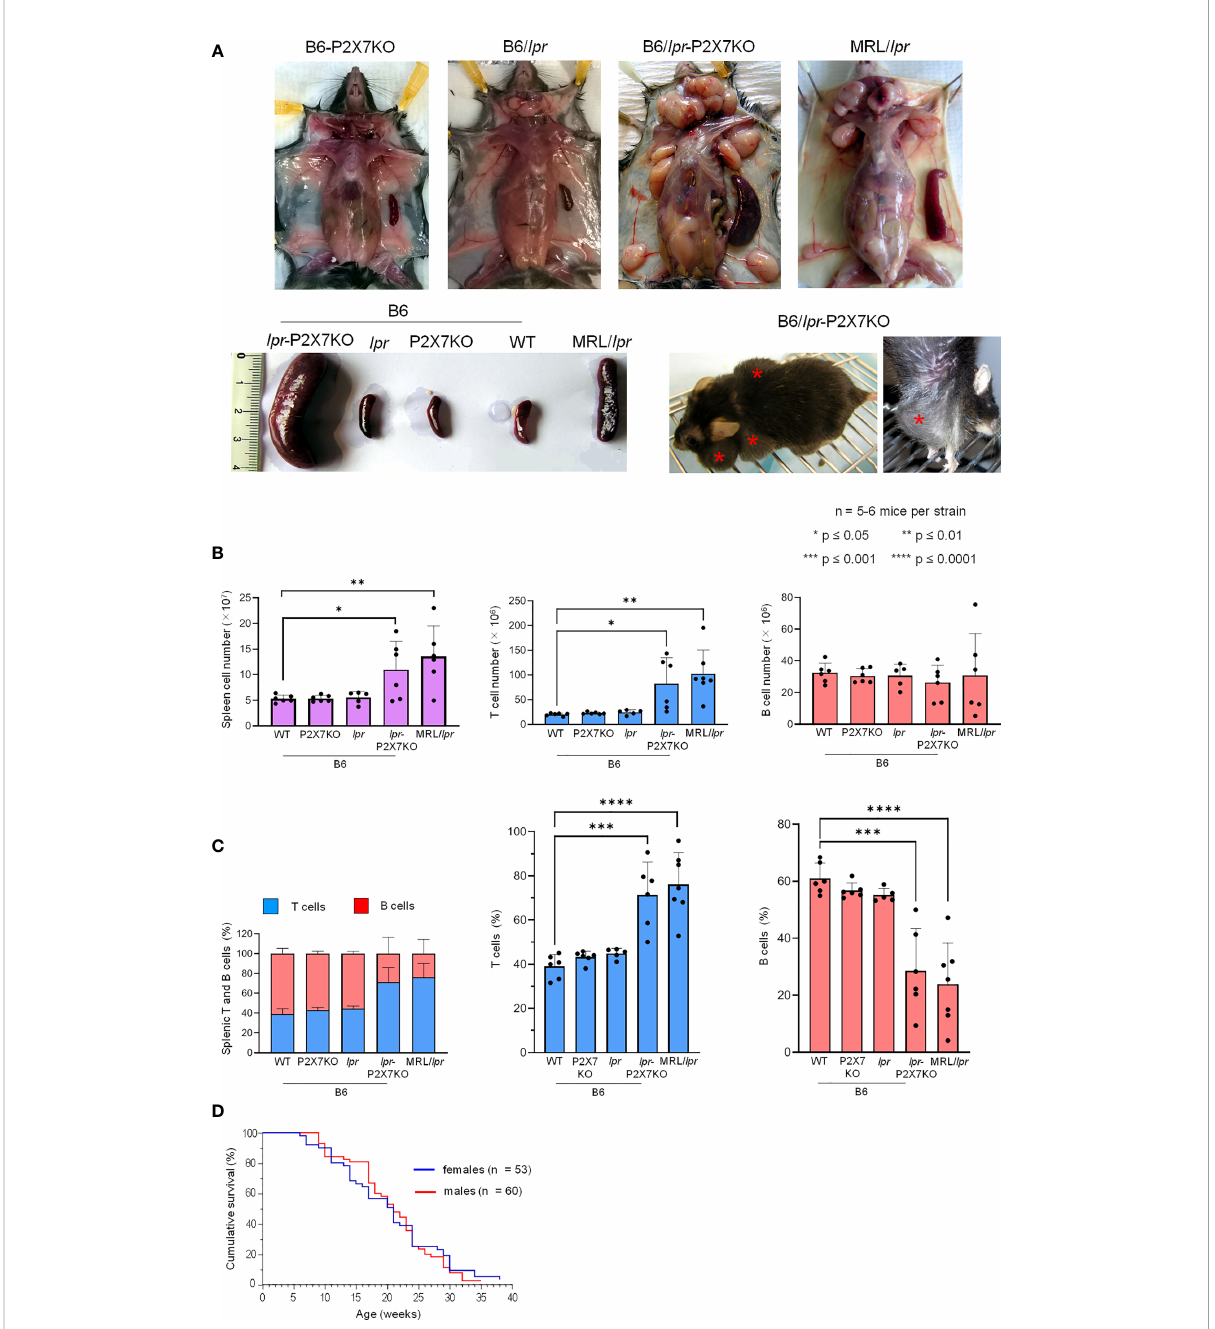
DC FIGURE 1 B6 /lpr-p2x7 KO mice show a shortened lifespan and develop massive hyperplasia of the secondary lymphoid organs with aging due to the accumulation of T lymphocytes.Representative images of cervical, axillary, and inguinal lymph nodes and spleens (A) of 7- to 8-month-old female B6 (WT), B6- p2x7 KO, B6/ lpr and B6/ lpr - p2x7 KO mice and 4-month-old female MRL/ lpr mice. The massive hyperplasia of lymph nodes is noticeable in a whole body image of living B6/ lpr - p2x7 KO mice (A, bottom panel, red asterisks). (B, C) Spleen cells of 7- to 8-month-old female WT, B6- p2x7 KO, B6/ lpr and B6/ lpr - p2x7 KO mice and 4-month-old female MRL/ lpr mice were stained with either fl uorescent mAbs against phenotypic markers CD90 and B220 or isotype controls and analyzed by fl ow cytometry. Bar graphs show the absolute number (B) and percentage (C) of splenic leukocytes ( ), CD90 + T cells ( ) and CD90 − B220 + B cells ( ) from each mouse strain. Stacked bar graphs show the respective proportions of the T and B cells in each mouse strain. Data are expressed as mean (SD) of 5-6 mice per strain, and each dot in the bar graphs represents an individual mouse. Error bars in graphs show SD. (D) Kaplan-Meier graph showing the cumulative survival rate by age for female (n = 53) and male (n = 60) B6 /lpr - p2x7 KO mice. Asterisks above horizontal lines indicate statistically signi fi cant differences assessed with unpaired two-tailed t -test. *p ≤ 0.05, **p ≤ 0.01, ***p ≤ 0.001 ****p ≤